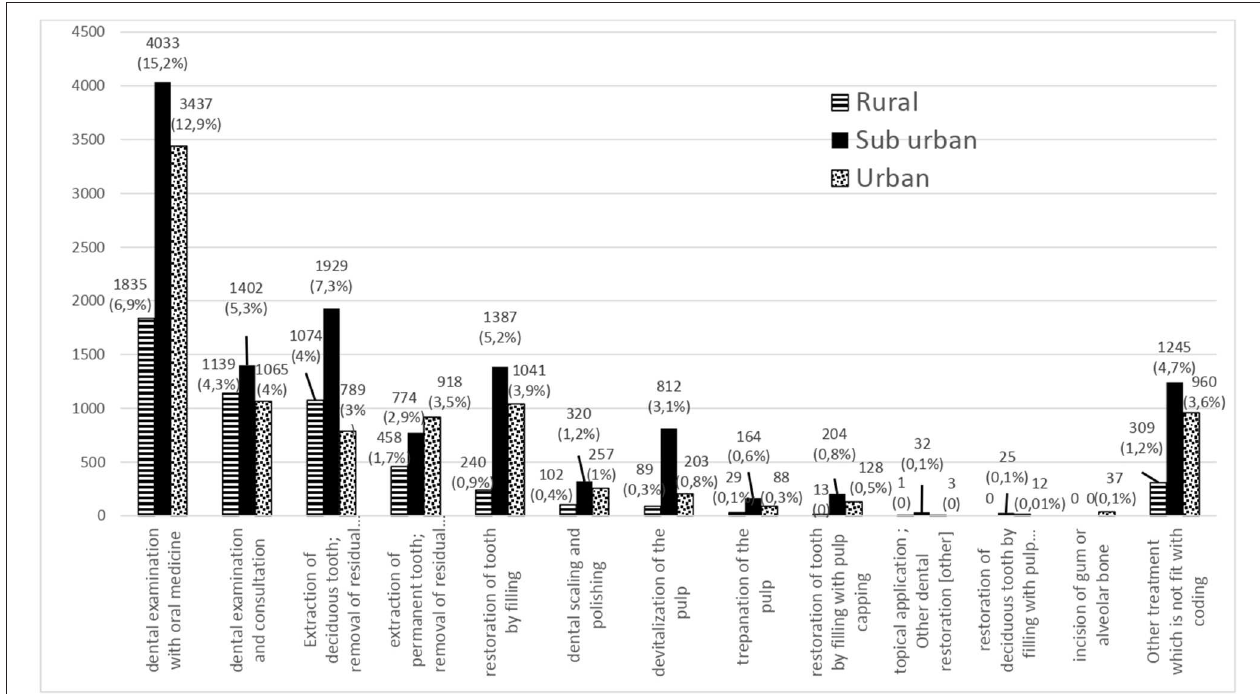
FIGURE 1 | Dental disease patterns in urban, suburban, and rural areas of the Special Region of Yogyakarta in